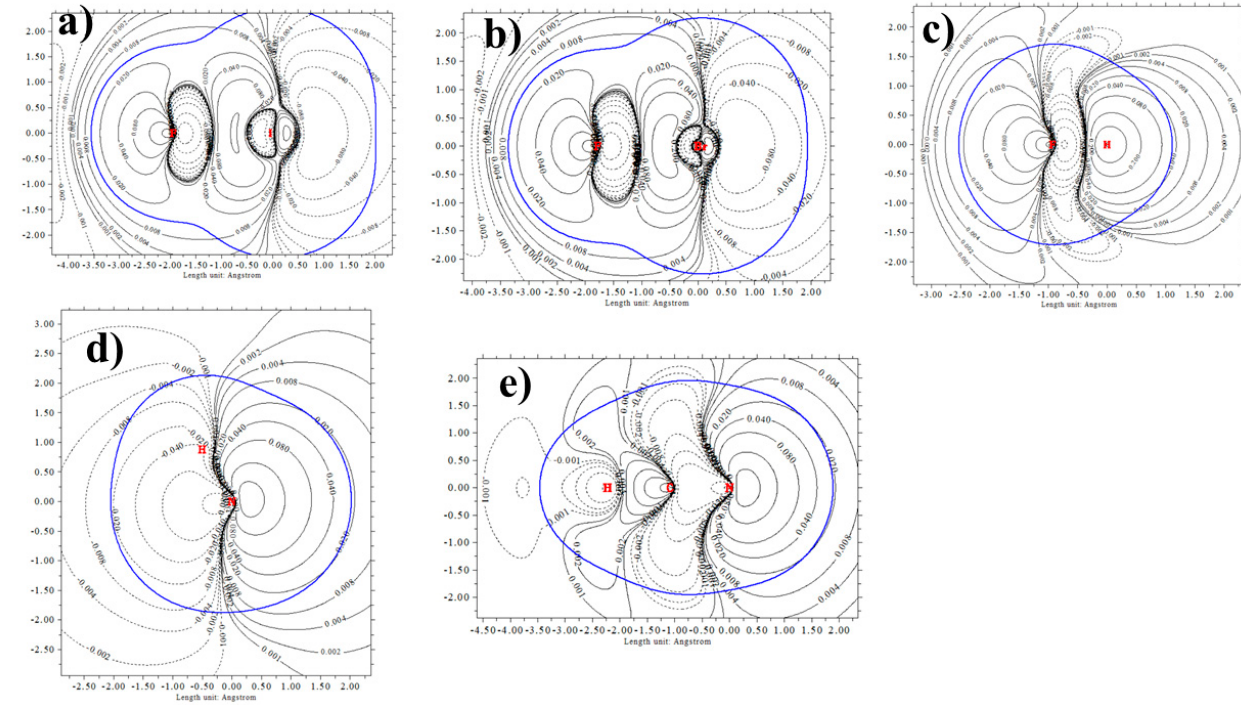
Figure 6. Contour plots of the σ *(FX) antibonding orbital ( a ) FI, ( b ) FBr, ( c ) FH, and the N lone pair orbitals of ( d ) NH 3 and ( e ) NCH. Blue line represents a vdW surface defined as isodensity ρ = 0.001 au.